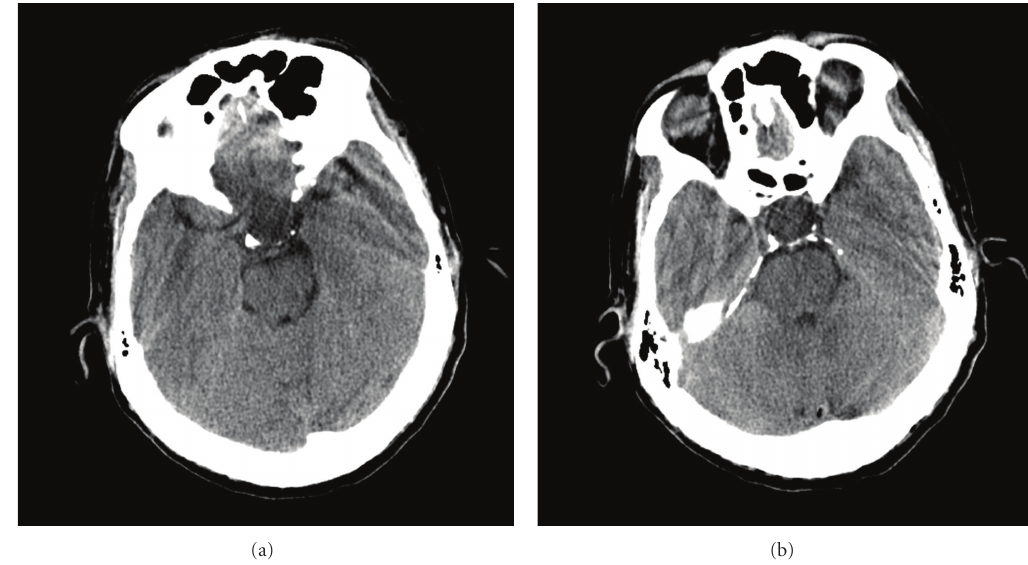
Figure 1: Noncontrast head CT in May revealing an enlarged sella turcica without evidence of calcifications, most consistent with a sella- suprasellar cystic mass.